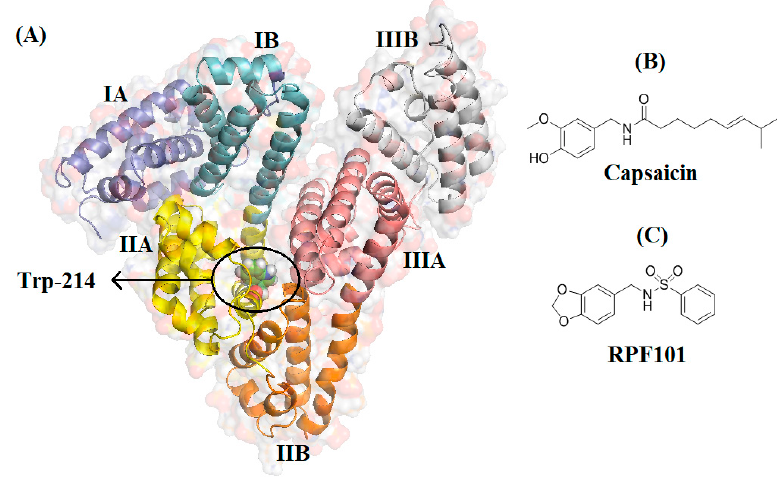
Figure 1. ( A ) Human serum albumin (HSA) structure as cartoon representation and tryptophan-214 (Trp-214) residue as green stick. ( B , C ) Chemical structure of capsaicin and its analogue RPF101